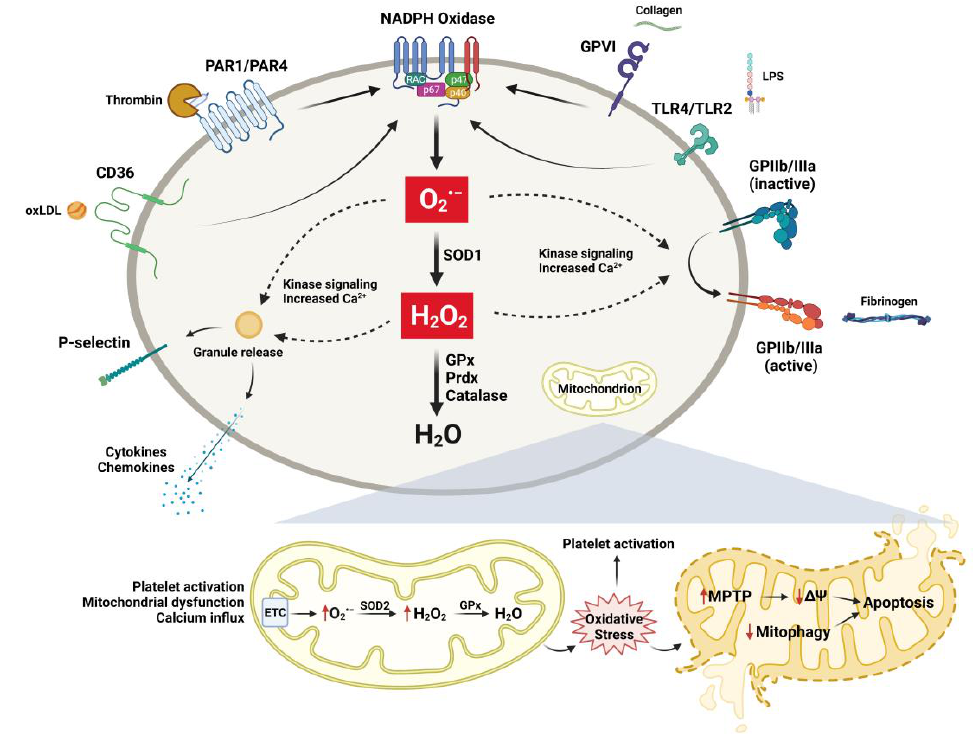
Figure 2. Selected mechanisms of platelet activation and ROS generation in aging and age-associated disease. A variety of extracellular ligands can associate with their respective platelet receptors and induce platelet activation and ROS generation. Multiple sources, including NADPH oxidases and mitochondria, can increase intracellular ROS in platelets. ROS generation in the cytoplasm can activate platelet surface receptors and induce granule release mediated by kinase signaling cascades and increased intracellular calcium. Dysfunctional mitochondria can produce increased ROS and result in mitochondrial permeability transition pore (MPTP) formation, loss of mitochondrial mem- brane potential (ΔΨm), and induction of platelet apoptosis. Antioxidant enzymes localized in both the cytoplasm and the mitochondria can reduce ROS and prevent platelet activation and apoptosis.